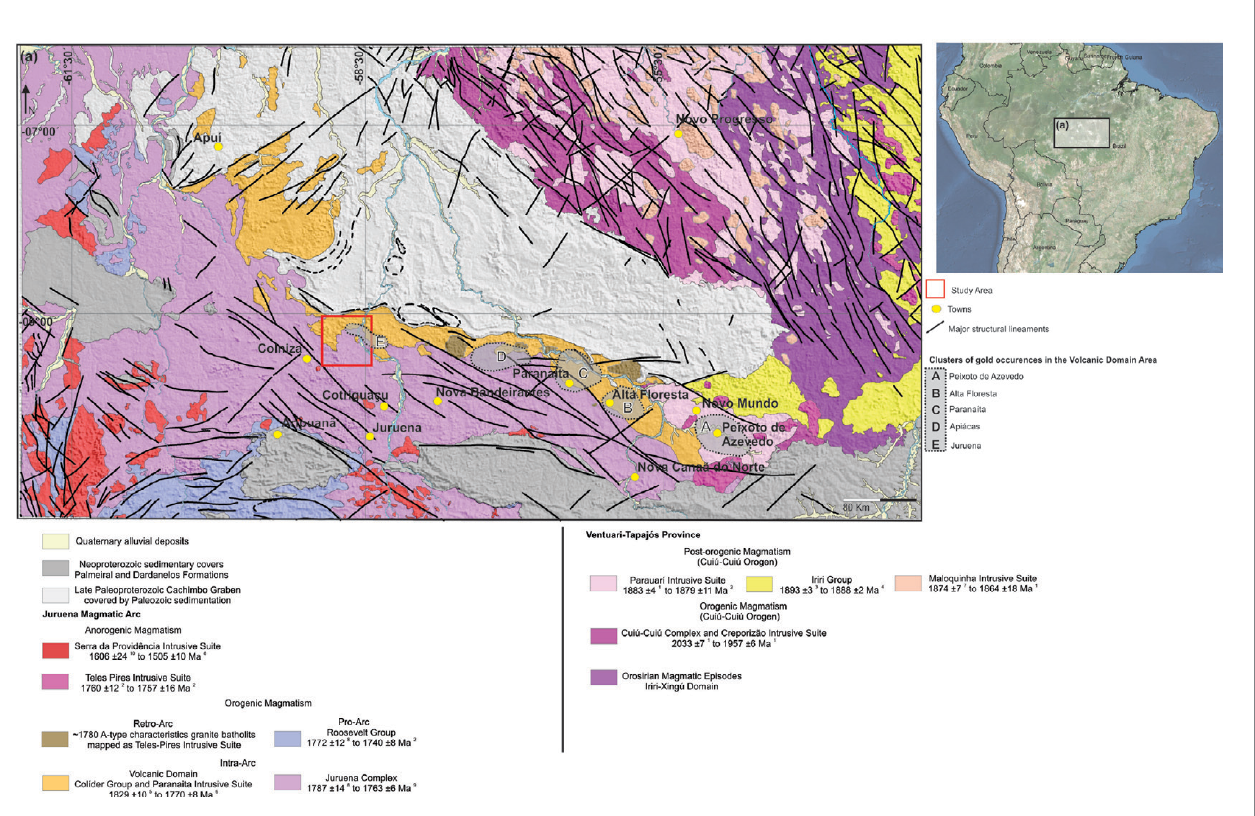
FIGURE 17 - Geotectonic and simplified geological map of part of the SW Amazon Craton. Letters A to E are showing the occurrence of gold clusters of the Alta Floresta Gold Province in the Volcanic Domain. The geology and major structural features were modified from the geological map of Brazil, 1:1.000.000 scale (Bizzi 2003). U-Pb crystallization ages reference: 1 Santos et al. (2001); 2 Santos et al. (2000); 3 Vasquez et al. (1999); 4 Dall’Agnol et al. (1999); 5 Present data; 6 Pinho et al. (2003); 7 Vasquez et al. (2008); 8 Ribeiro and Duarte (2010); 9 Neder et al. (2002); 10 Bettencourt et al. (1999); 11 Rizzotto